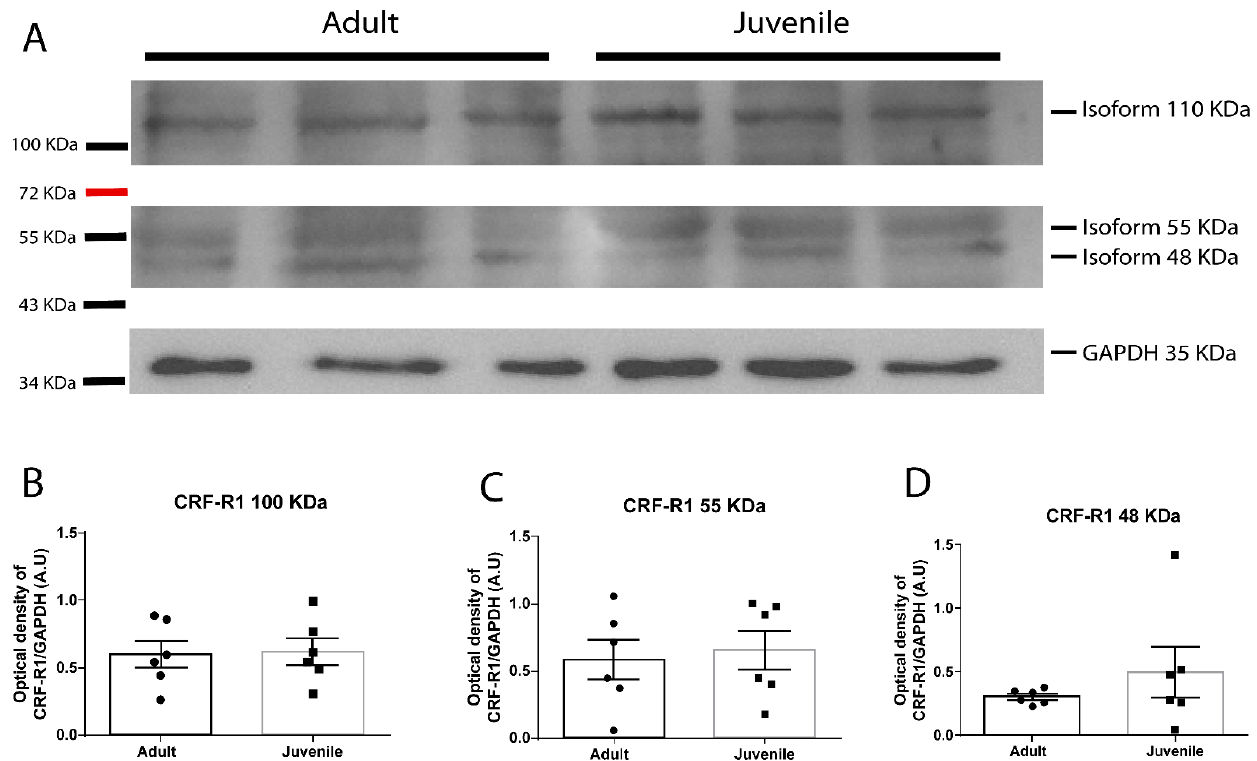
Figure 4. CRF-R1 protein levels in juvenile versus adult rats. Comparison of CRF-R1 protein levels between juvenile and adult rats using Western blot. ( A ) CRF-R1 predicted band size is 48 kDa. We identified three isoforms of CRF-R1 as the two bands below 55 kDa and the band upon 100 KDa. The band above 35 kDa corresponds to GAPDH. ( B ) Quantification of the optical densities of the 100 KDa CRF-R1 band normalized to the optical densities of the GAPDH band. Non-paired Student’s t -test revealed that 100 KDa CRF-R1 levels were not different in juvenile animals compared to adults (t = 0.1295, df = 10, p = 0.8996). ( C ) Quantification of the optical densities of the 55 KDa CRF-R1 band normalized to the optical densities of the GAPDH band. Non-paired Student’s t -test revealed that 55 KDa CRF-R1 levels were not different in juvenile animals compared to adults (t = 0.3259, df = 10, p = 0.7512). ( D ) Quantification of the optical densities of the 48 KDa CRF-R1 band normalized to the optical densities of the GAPDH band. Non-paired Student’s t -test revealed that 48 KDa CRF-R1 levels were not different in juvenile animals compared to adults (t = 0.9791, df = 10, p =